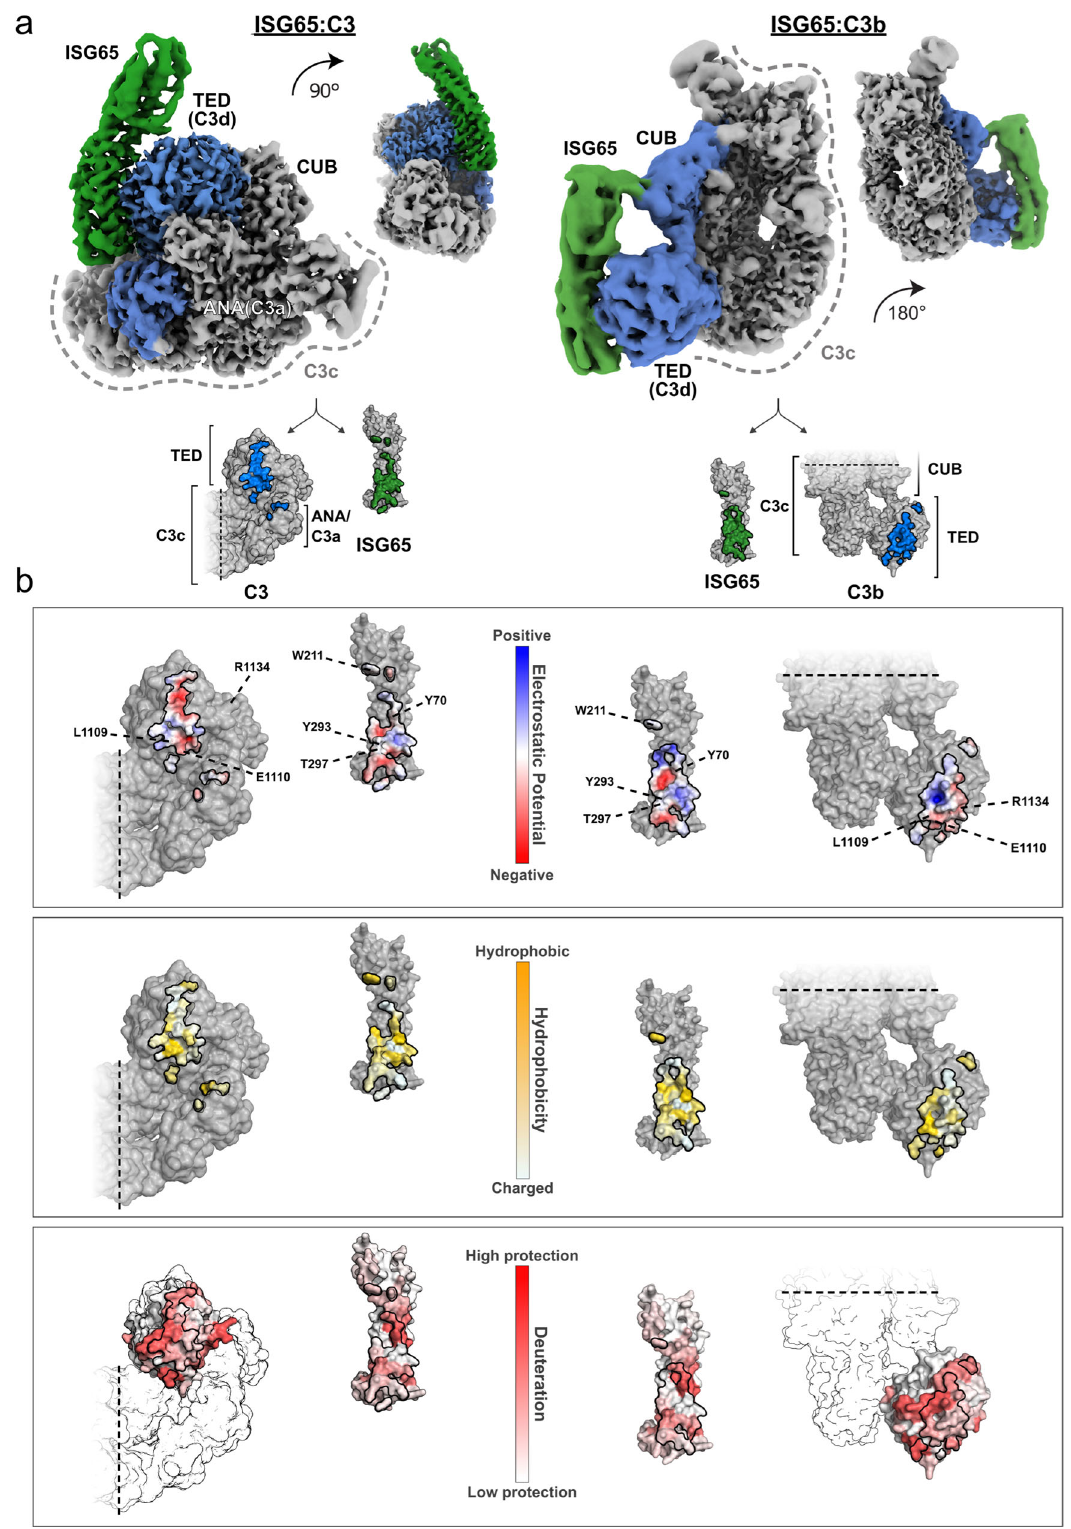
Fig. 6| Cryo-EMstructuresofISG65incomplexwithnativeC3and C3b.a Cryo- EMdensitymapsshowingsideviewsofISG65:C3(left),andISG65:C3b(right)attwo different angles. ISG65 is represented by map regions coloured in green. Interact- ing domains in C3 and C3b are depicted in blue. In both C3 conformations, TED provides the primary interface. ISG65 and TED show a high degree of shape com- plementarity.Smaller,secondaryinterfacesarelocatedinANA(nativeC3)andCUB (C3b). The remaining scaffold (C3c, grey) shows no additional contact points